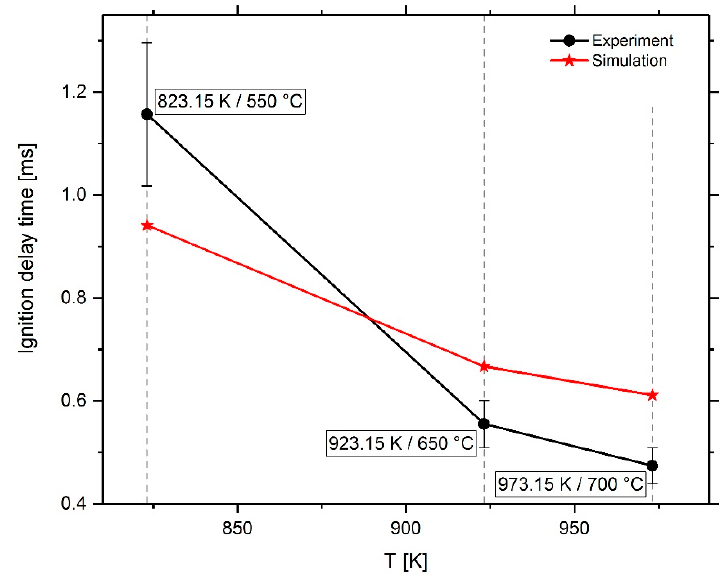
Figure 11. Measured and simulated IDT of pilot fuel in air as a function of temperature.